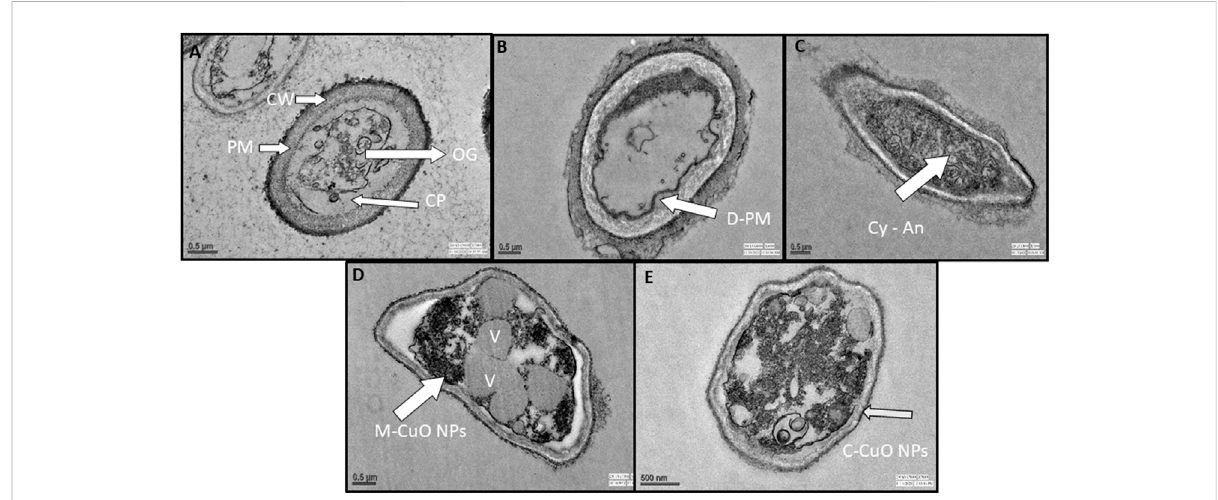
FIGURE 14 TEM ultrastructure analysis: (A) micrographs of A. brassicae (control) showing regular cell wall (CW), plasma membrane (PM), cytoplasm (CP), and organelles (OG); (B) tested fungi treated with 2000 ppm of mancozeb resulted in delocalization of plasma membranes, cytoplasmic disorder (Cy - An); (C) propiconazole (0.05%) resulted in the damage of cell wall and hardly recognizable organelles; (D) M - CuO NPs accumulated inside the cytoplasm, and delocalized cell organelles, leads to large number of vacuoles at 200 ppm in broth assay after 10 days; (E) C - CuO NPs also entered cytoplasm and creates an imbalance in all organelles, leads to an increased